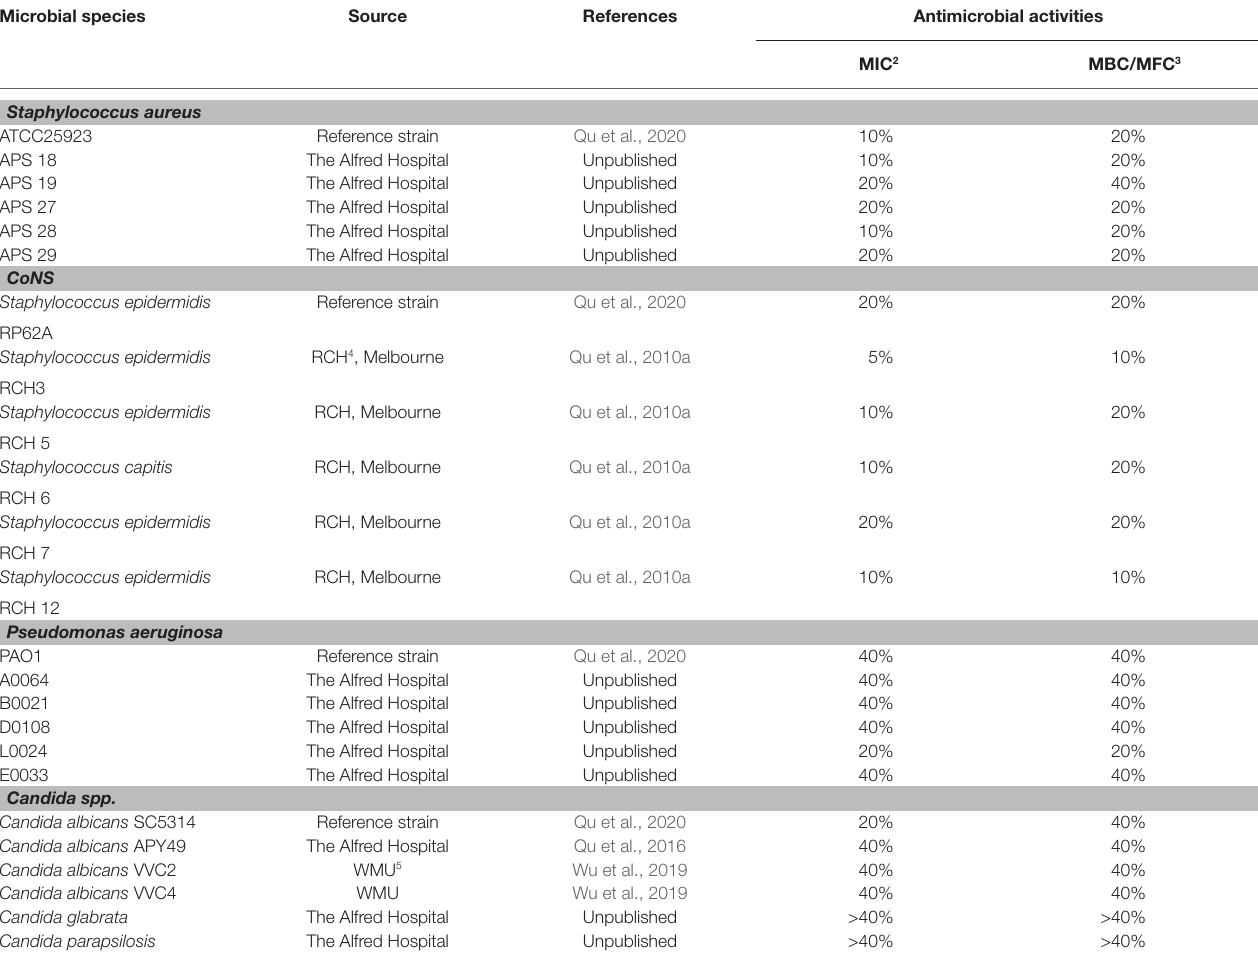
Microbial species